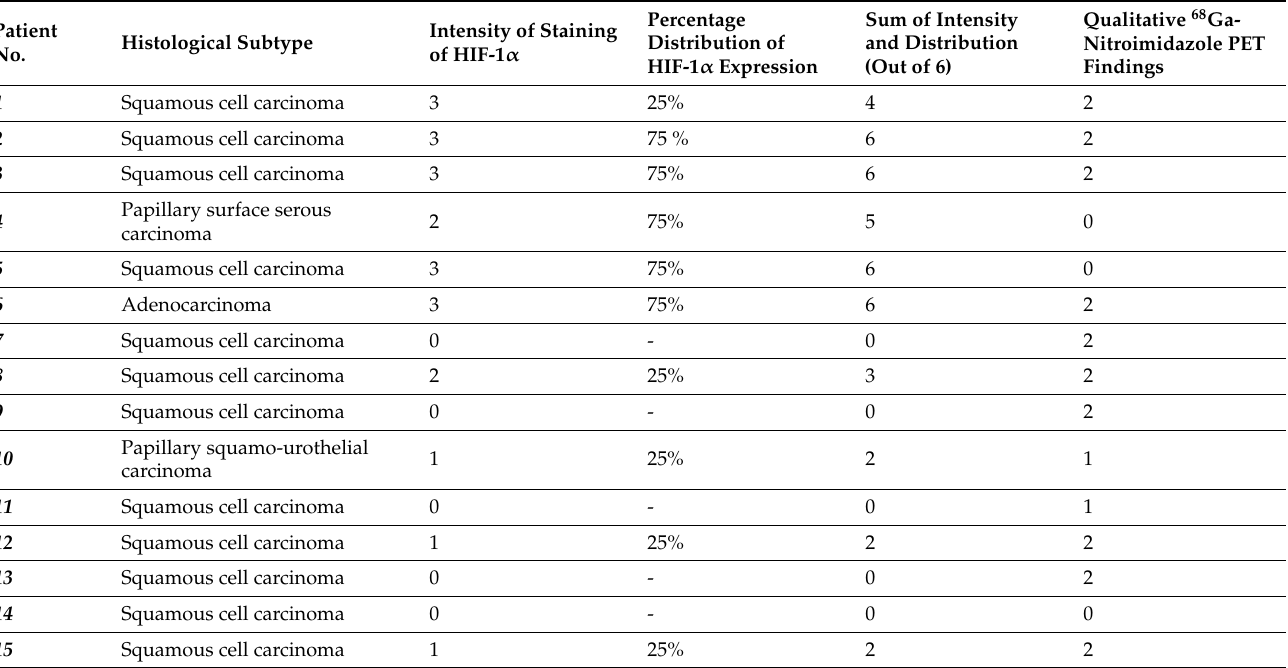
Table 2. Immunohistochemical analysis and correlation to 68 Ga-Nitroimidazole imaging qualitative assessment.